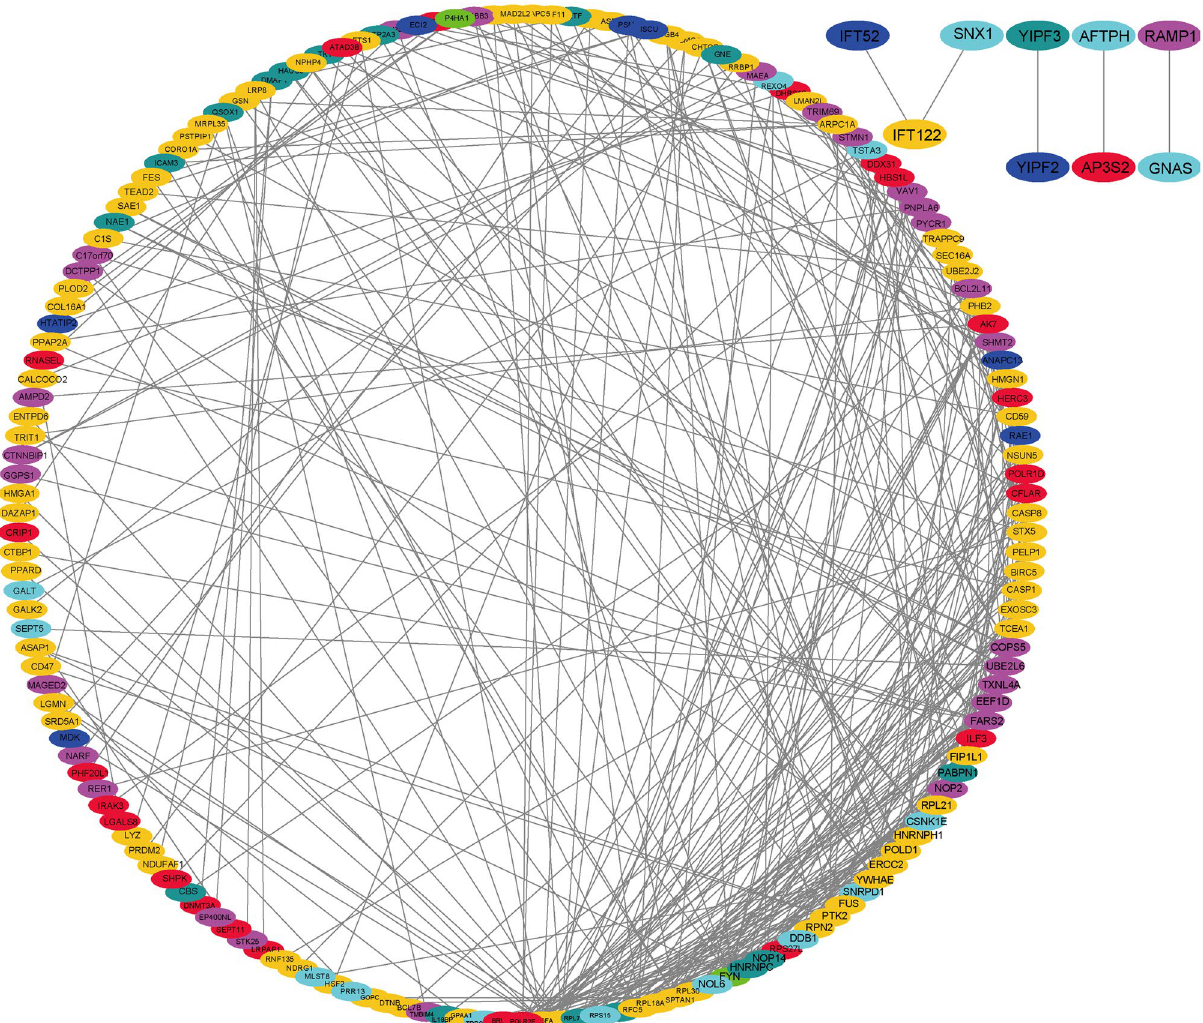
Figure 3. The gene interaction network significantly related to overall survival. The different colors correspond to different AS-event subtypes, where yellow represents ES events and red represents ES events, according to the annotation on diagram. The ES event related genes, such as VEGFA, NME1, PTK2, and RFC5, showed significant interactions with the 267 genes associated with overall survival